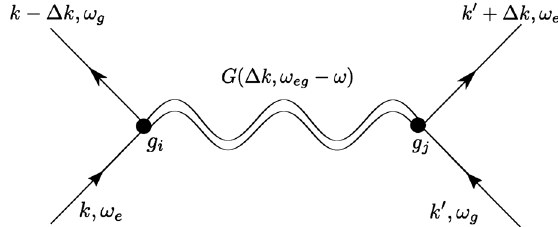
FIG. 2. The Feynman diagram describing the effective inter- actions between